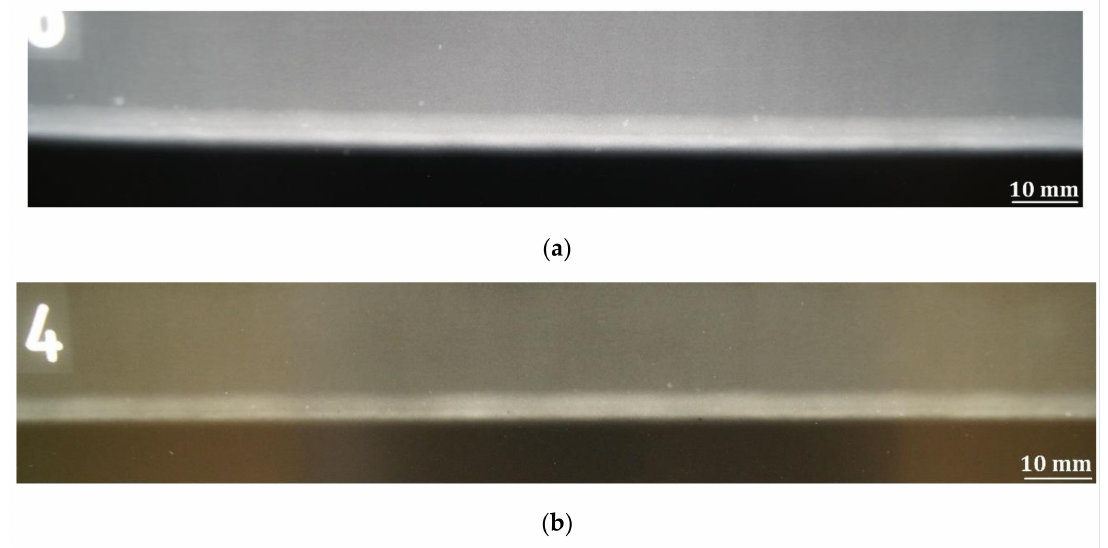
Figure 7. X-ray photograph of the hybrid-welded joints: ( a ) joint no. 1 (PA) and ( b ) joint no. 2 (PC).